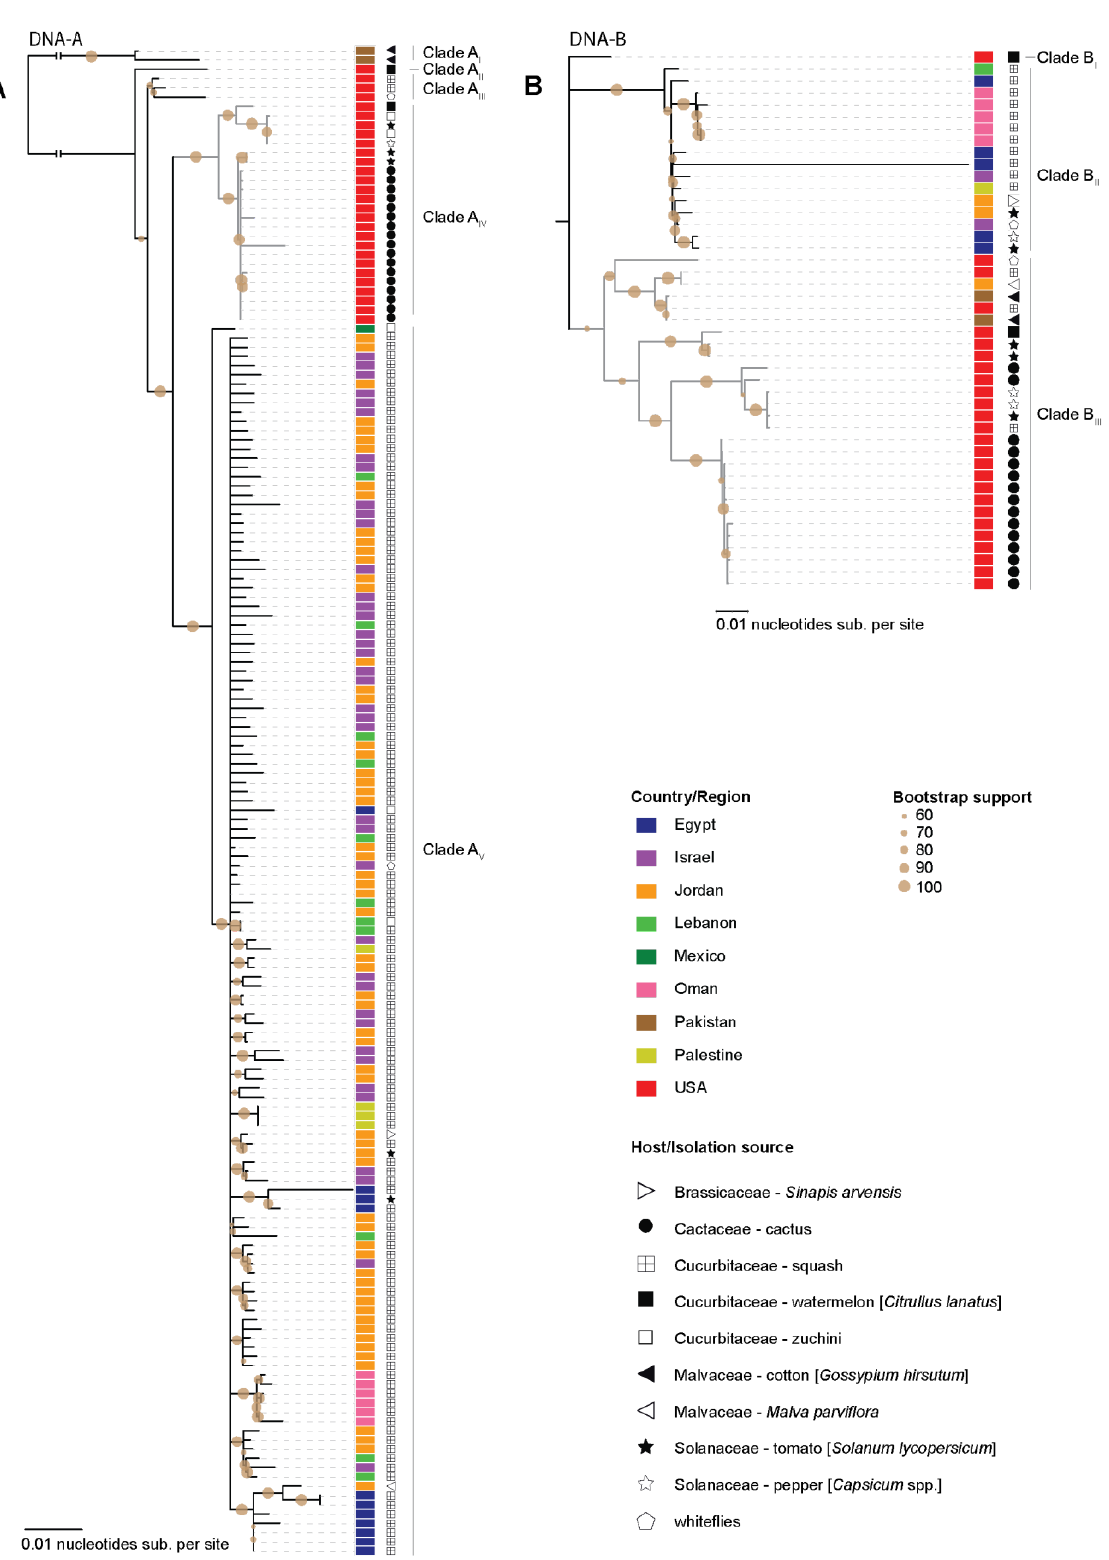
Figure 2. Maximum-Likelihood phylogenetic tree of the SCLV ( A ). DNA-A and ( B ). DNA-B component sequences. The country from which the sequences have been identified are color coded and the host/isolation source is marked by symbols. Clades containing the sequences from this study are colored in grey.